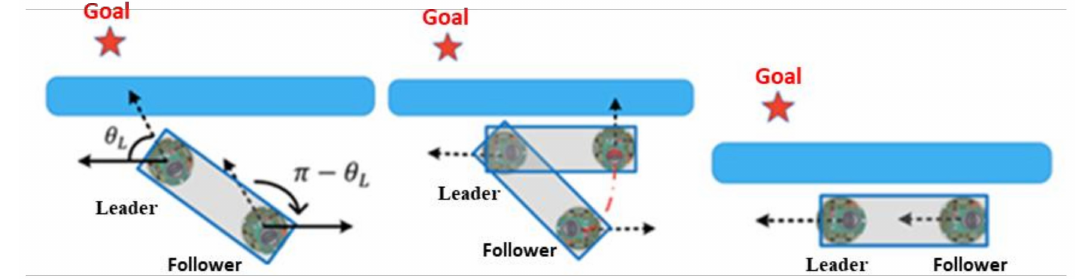
Figure 19. Actions of the follower.